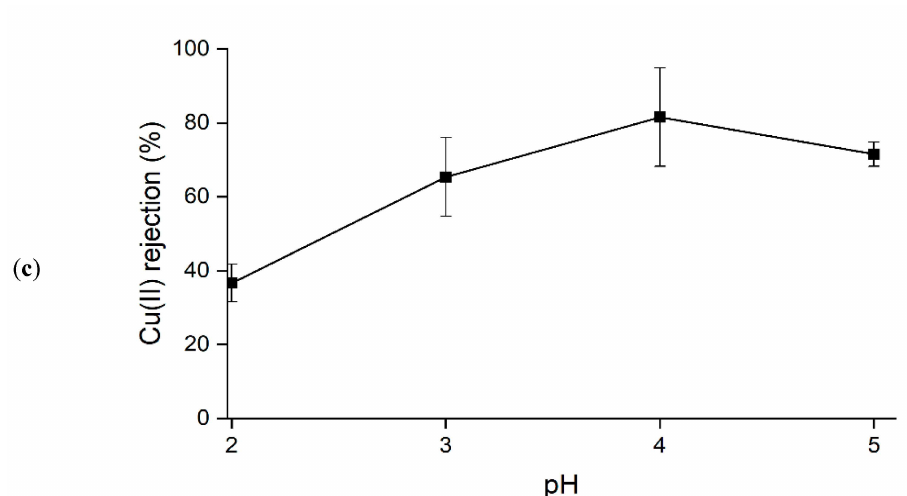
Figure 3. Cu(II) ions rejection (%) at different ( a ) feed concentration (ppm), ( b ) feed pressure (bar), and ( c ) pH value, respectively.